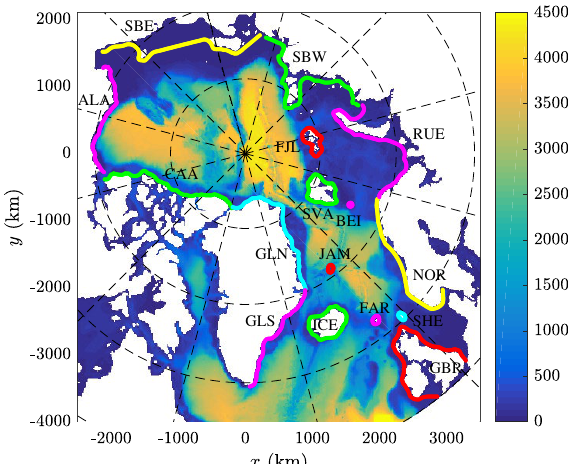
Figure 1. Map of the domain of study with particle release locations (see Table 1). The color shading shows depth in meters. (Map created with Matlab version 2016b, https:// www. mathw orks.